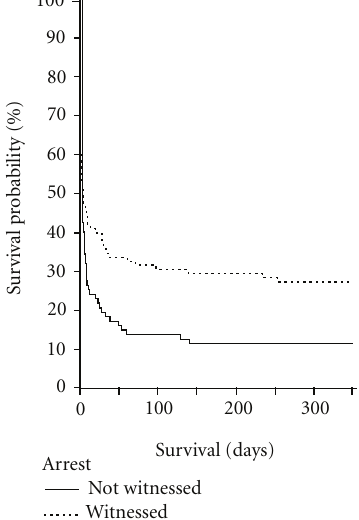
Figure 2: Kaplan-Meier survival curve for survival probability in relation to witnessed arrests ( P = 0 .